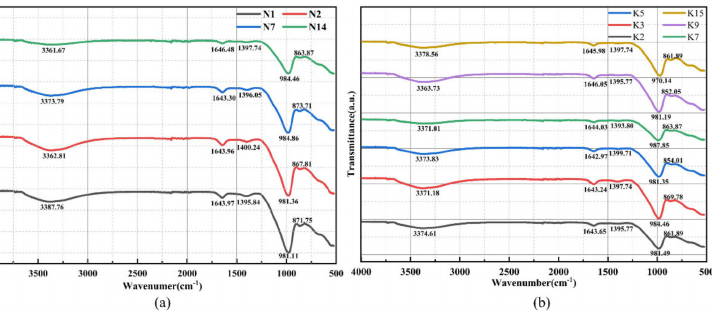
Figure 7. The 28-day FTIR spectra of geopolymers: ( a ) FTIR spectrum of Na − based geopolymers and ( b ) FTIR spectra of K − based